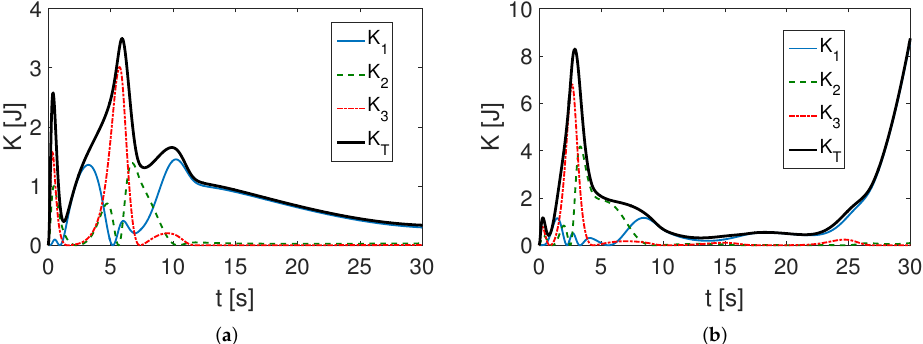
Figure 4. Changes in kinetic energy ( K 1 , K 2 , K 3 , K T ) during motion—results with 50% parameter increase in parameter values: ( a ) sine trajectory; ( b ) complex